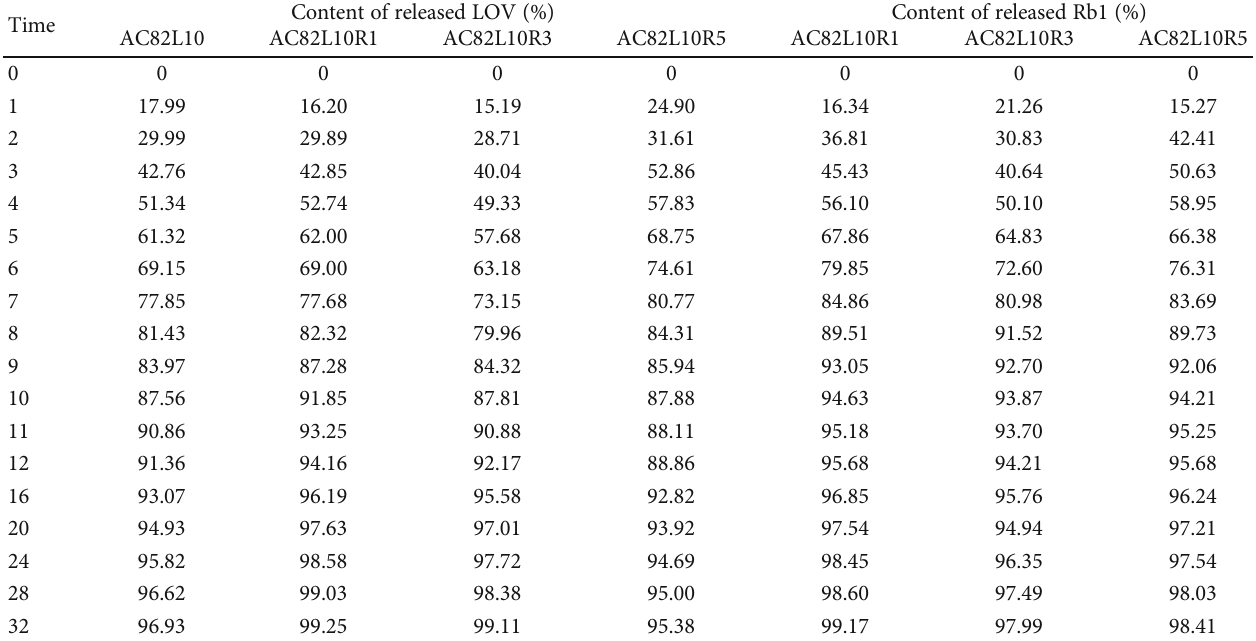
Table 4: The content of LOV and Rb1 released from AC82L10R x composite fi lms in pH 4.5 solution. Time